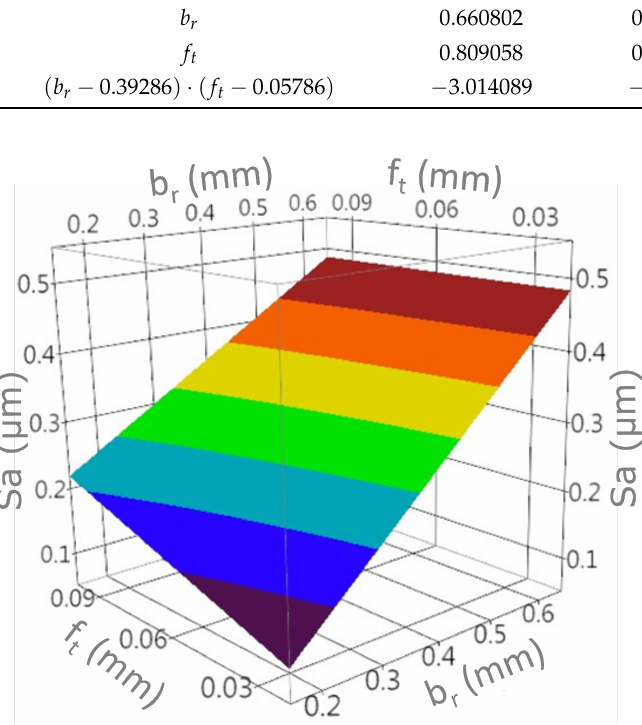
Figure 11. The response surface for the model with the Sa output